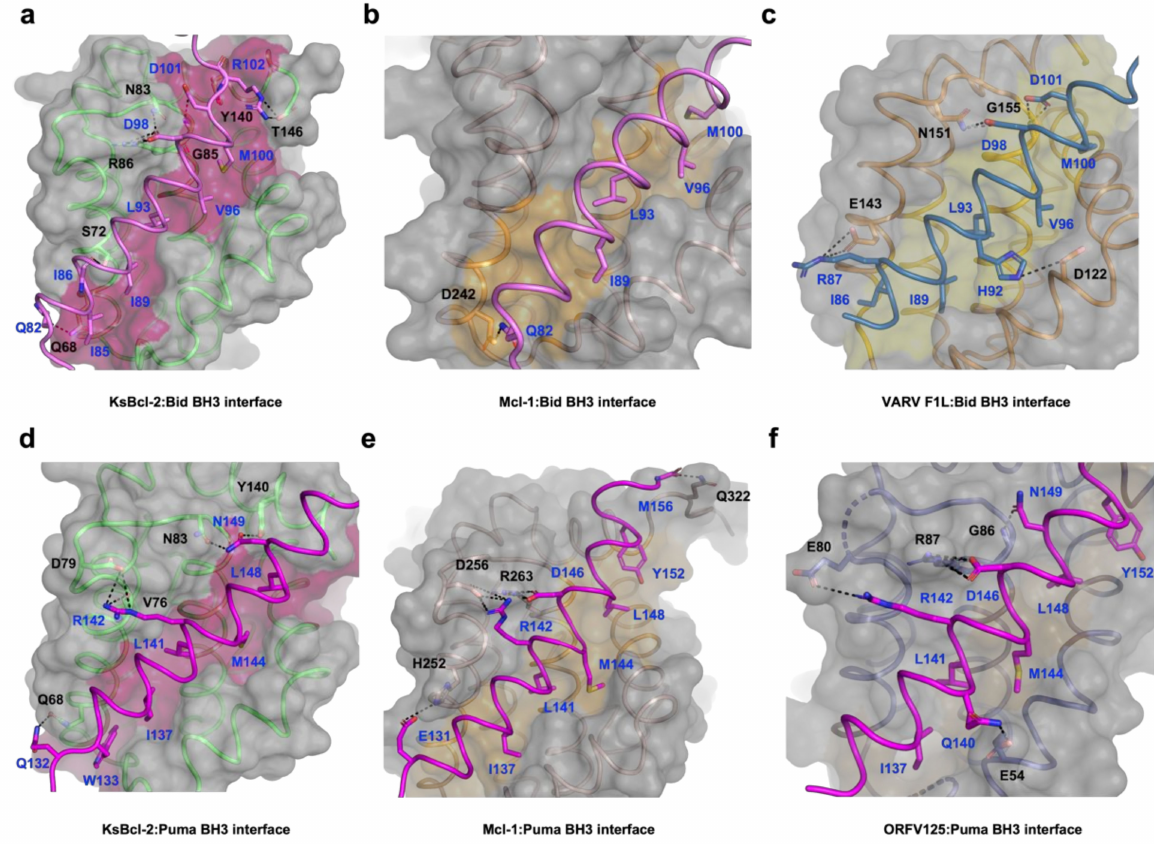
Figure 2. Detailed view of the KsBcl-2:Bid BH3, KsBcl-2:Puma BH3, Mcl1:Bid BH3 and Mcl1:Puma BH3 interfaces. The KsBcl-2 surface, backbone and floor of the binding groove are shown in grey, green and hot pink, respectively. ( a ) KsBcl-2: Bid BH3 interface where Bid BH3 is shown in pink. The five key hydrophobic residues of Bid BH3 (I85, I89, L93, V96 and M100) protruding into the binding groove and the conserved salt-bridge formed by KsBcl-2 R86 and Bid BH3 D98 are labelled, as well as all other residues involved in additional ionic interactions and hydrogen bonds. Interactions are denoted as dashed black lines. ( b ) Molecular surface of human Mcl-1 (brown ribbon): Bid (pink) BH3 is shown as in ( a ). The four key hydrophobic residues of Bid BH3 (I89, L93, V96 and M100) are protruding into the binding groove, and the residues involved in hydrogen bonds are labelled. Interactions are denoted as black dotted lines. ( c ) VARV F1L (orange):Bid BH3 (pink) with the surface of VARV F1L is shown as in ( a ) and the floor of the binding grove is shown in yellow. The five key hydrophobic residues of Bid BH3 (I86, I89, L93, V96 and M100) are protruding into the binding groove and the salt bridge formed by Bid R87 and VARV F1L E143 is labelled, as well as residues involved in hydrogen bonding. ( d ) KsBcl-2: Puma BH3 with the surface of KsBcl-2 is shown as in ( a ), and Puma BH3 is shown in magenta. The five key hydrophobic residues of Puma BH3 (W133,